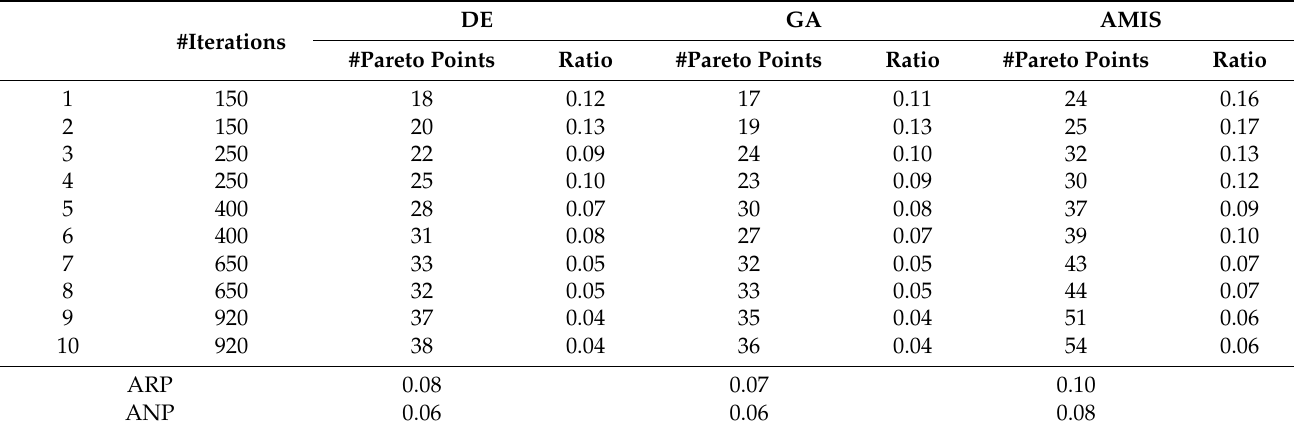
Table 22. ANP and ARP of all proposed